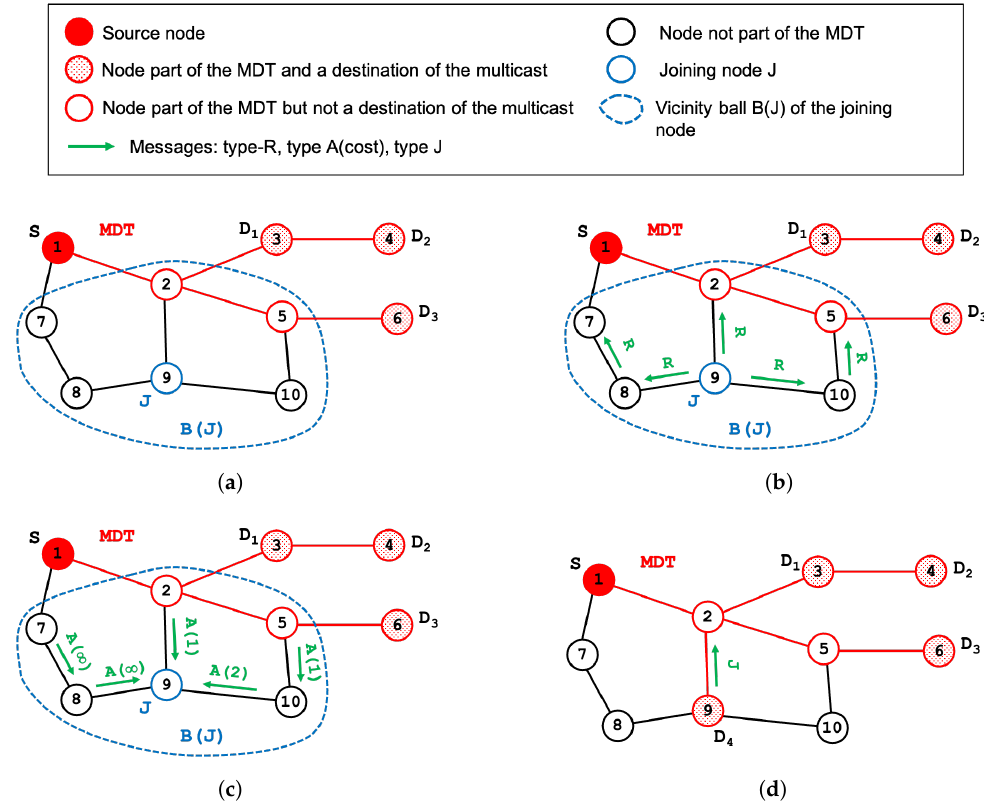
Figure 2. Creation of a branching path between a joining node and the MDT using local search: ( a ) initial situation with joining J and the MDT; ( b ) joining node searching messages within its vicinity ball; ( c ) nodes’ answers to the joining node; ( d ) node joins the MDT through the least cost branching